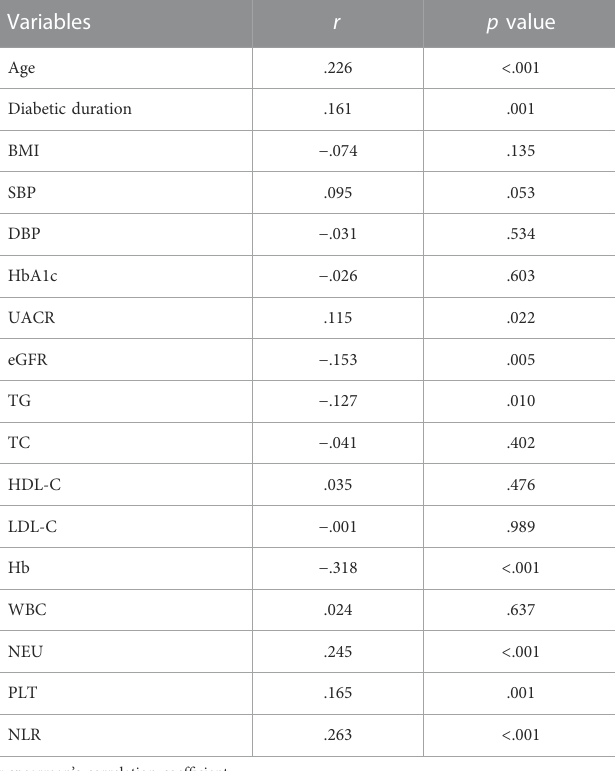
TABLE2RelationshipsbetweenFARandclinicalparametersinpatientswithT2D.